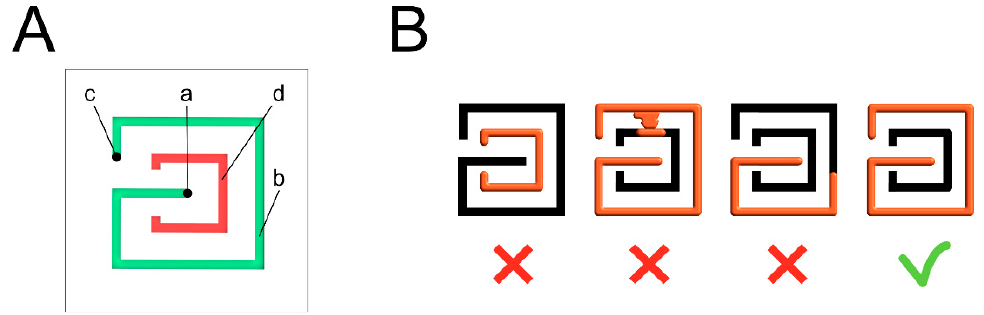
Figure 2. MT single tester cell. ( A ) Inlet (a), exercise path (b), correct filling indicator of the exercise path (c), correct infilling indicator at the inlet (control path) (d); ( B ) Schematic representation of the correct and incorrect loading and filling of the MT single tester cell.